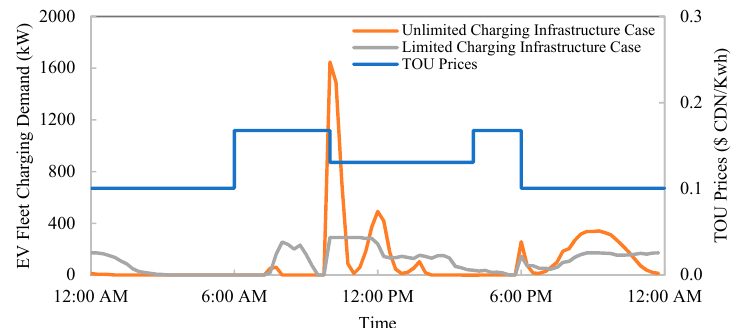
Figure 10 . Comparison of controlled EV fleet charging demand profiles between limited and unlimited charging infrastructure scenarios.